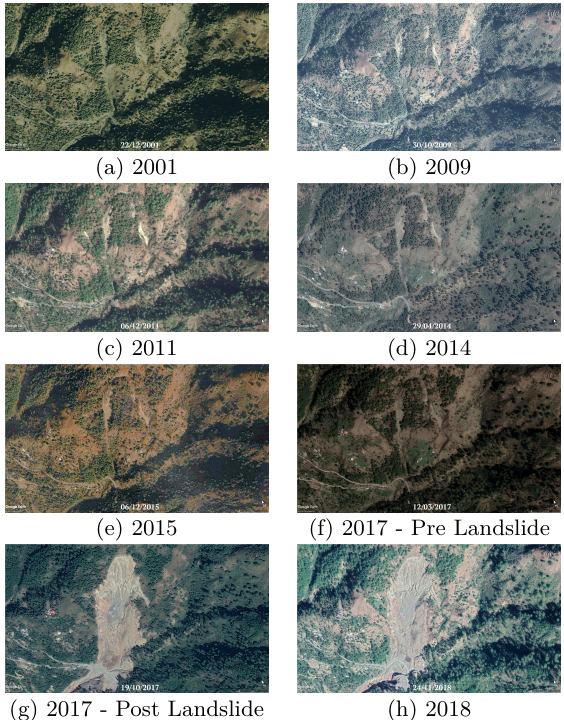
Figure 3. Landslide Reactivation – The existence of crack (Year 2001) can be clearly seen in (a). The development and enlargement of crack can be seen in subsequent images (b)-(f). Landslide occurrence can be seen in (g) and (h). Change in Road alignment is also visible the Himachal Pradesh, Uttarkashi earthquake 1991 of Ut- tarakhand and Gorkha earthquake in Nepal of 2015 (Pra- dhan et al., 2006).